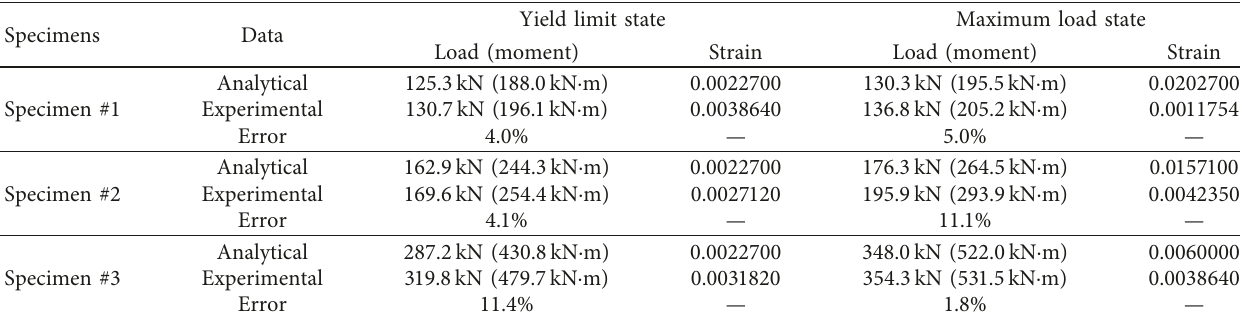
Table 8: Comparison of analytical values to test data at the yield and maximum load state (units: kN and kN · m) [19]. Specimens